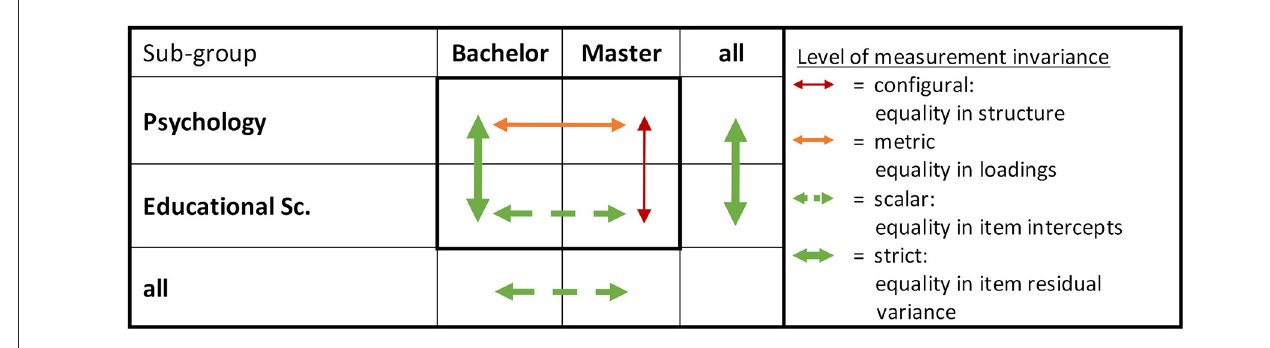
net. Validity coefficients are shown in Figure 1. Corresponding to H3, correlations supporting convergent validity were stronger than those supporting discriminant